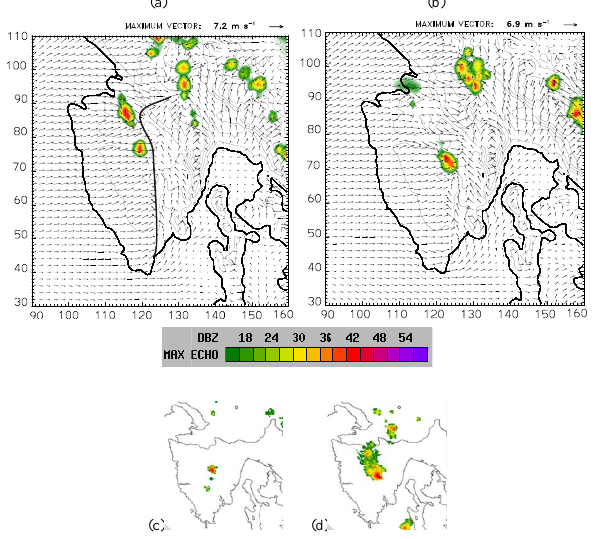
Fig. 11. (a, b) Diurnal evolution of the modelled near-surface wind (in ms − 1 , at 10ma.g.l.) associated with the maximum simulated equivalent radar reflectivity factor (dBZ) on 8 June 2003 at (a) 13:00CET and (b) 14:00CET. The every second wind vector is depicted with reference vectors near the upper right-hand corner and the thick black solid line in (a) indicates the position of the main convergence zone. (c, d) Radar reflectivity factor (dBZ) in radar images (source: ARSO – www.meteo.si) on 8 June 2003 at (c) 12:50CET and (d) 14:00CET. The radar reflectivity is given with a 3dBZ